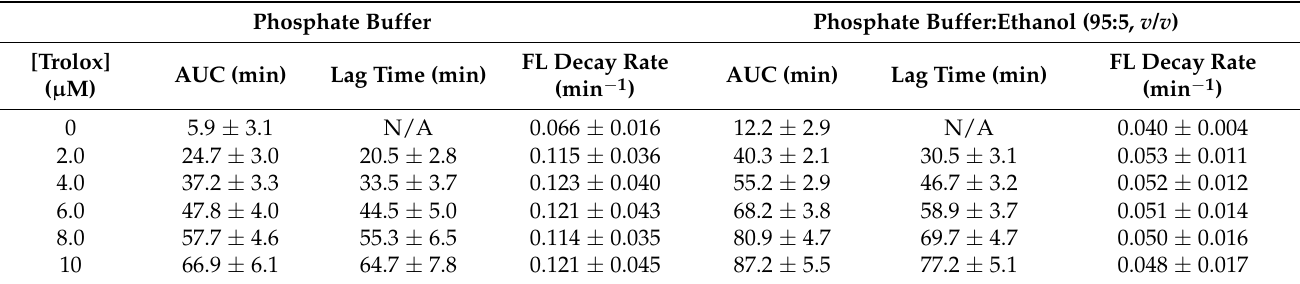
Table 2. Effect of ethanol content in AUC, lag time and FL decay rate values obtained for Trolox. Phosphate